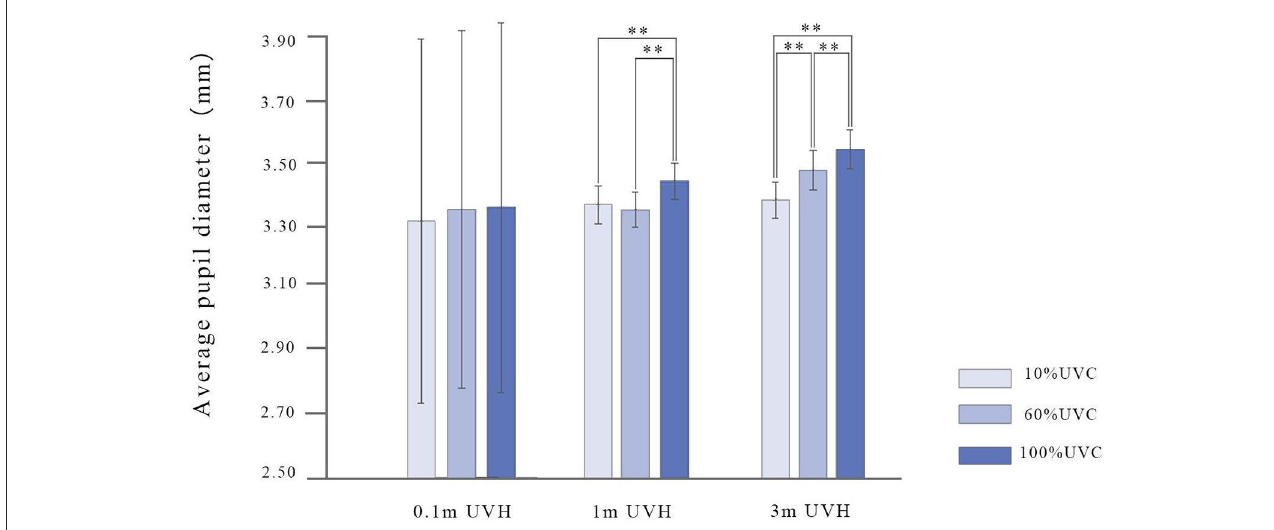
FIGURE8 The interaction of UVC and UVH on average pupil diameter. UVC, understory vegetation cover; UVH, understory vegetation height. ** p < 0.01.